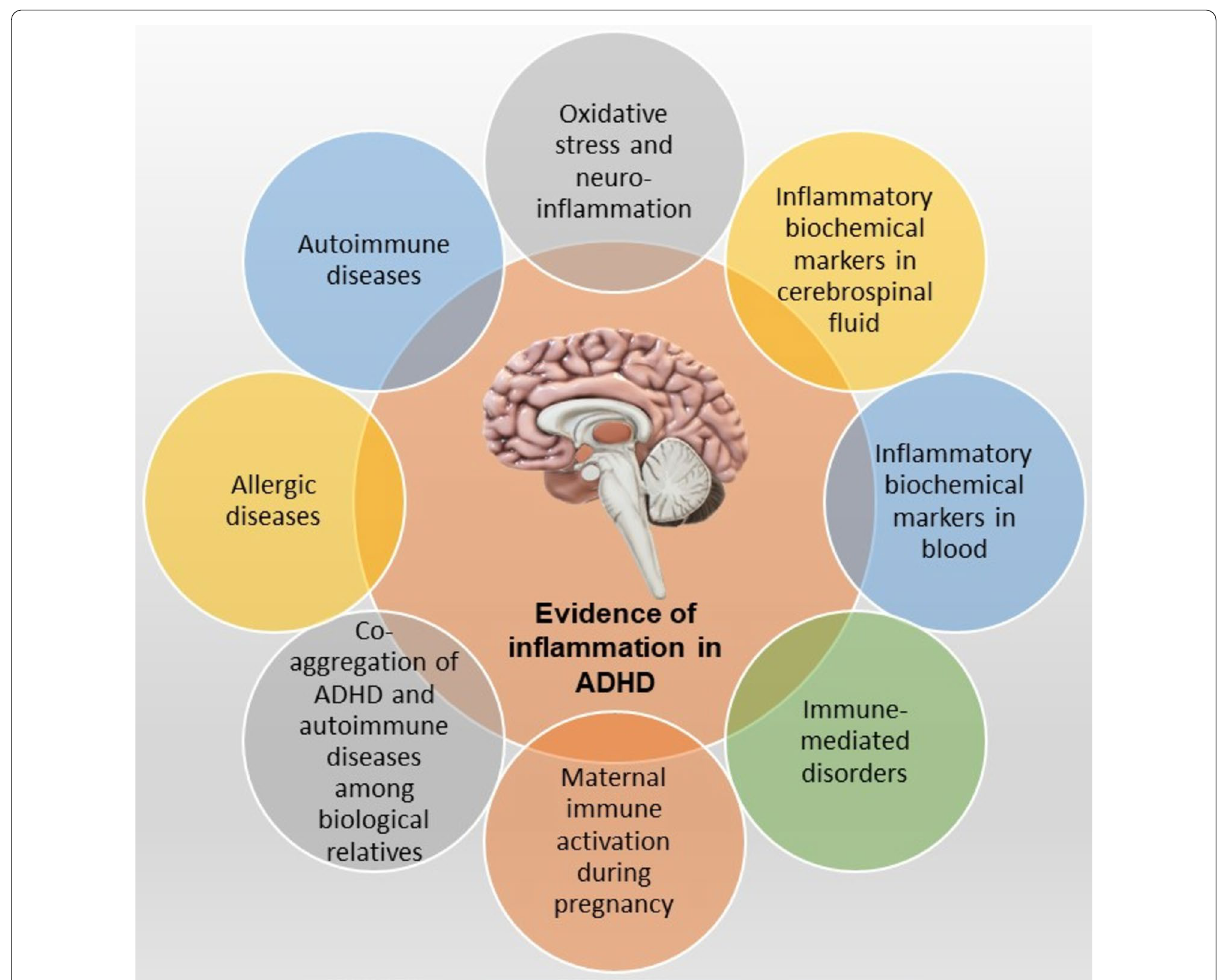
Fig. 1 Evidence of inflammation in ADHD The author declares that Fig. 1 is original. Its copyright belongs to the author, which ispassed to The Egyptian Journal of Neurology, Psychiatry and